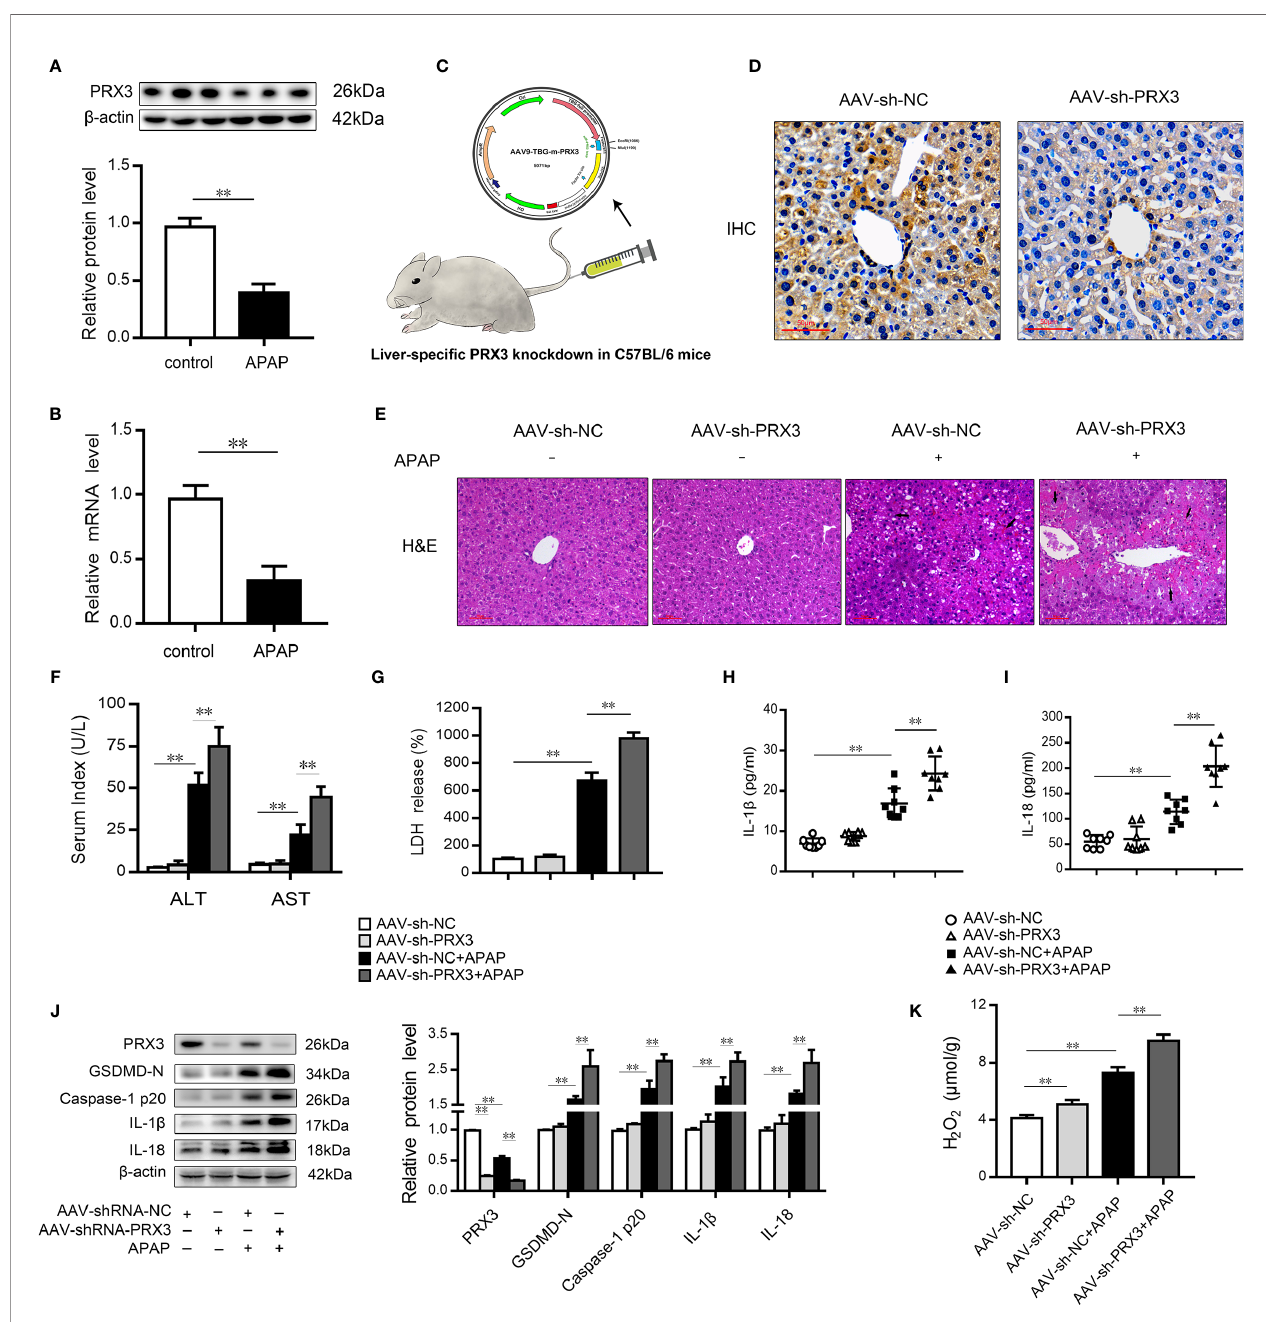
FIGURE 3 | PRX3 silencing accelerates pyroptosis in APAP-induced hepatotoxicity in mice. (A) PRX3 protein levels in mice liver were determined, n=3. (B) Liver PRX3 mRNA expression, n=6. (C) Schematic representation of AAV9-TBG-shRNA injection through tail vein in mice. (D) Liver sections were analyzed by immunohistochemical staining for PRX3 (50 m m). (E) Liver sections were stained with H&E (50 m m). The damaged areas are indicated with arrows. (F) Serum levels of ALT and AST were assessed, n=8. (G) Serum levels of LDH were assessed, n=8. (H, I) Serum levels of IL-1 b and IL-18, n=8. (J) PRX3, caspase-1 p20 and GSDMD-Nin mice liver were determined, n=3. (K) H 2 O 2 level, n =